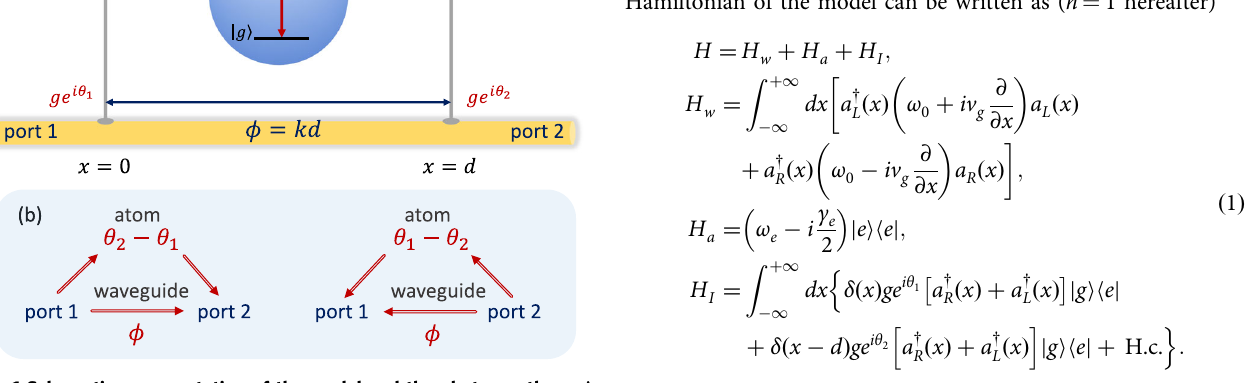
Fig. 1 Schematic representation of the model and the photon paths. a A two-level giant atom coupled to a waveguide at x = 0 and x = d , respectively, with individual local coupling phases θ 1,2 . b Two paths of a single photon propagating from port 1 to port 2 (left) or from port 2 to port 1